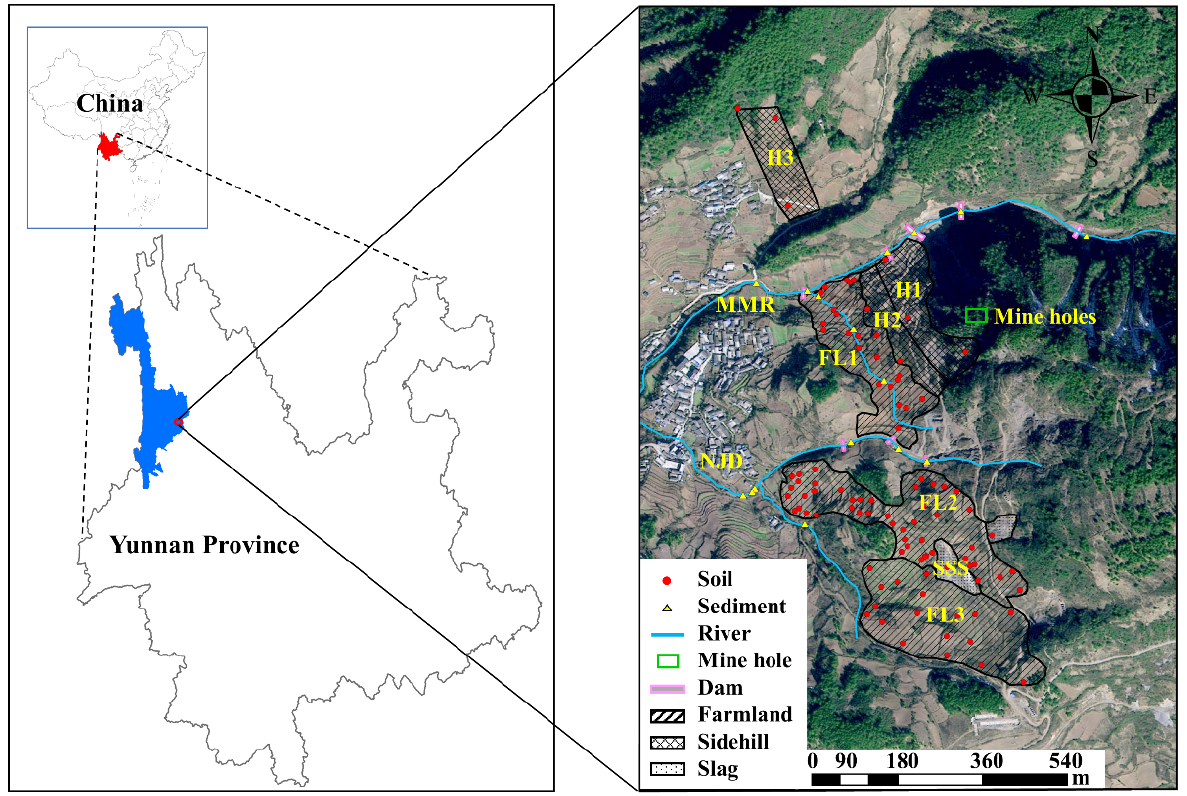
Figure 1. Location of the sampling sites.